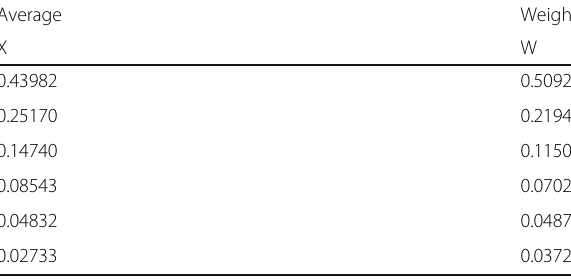
Table 3 Average and weight matrix